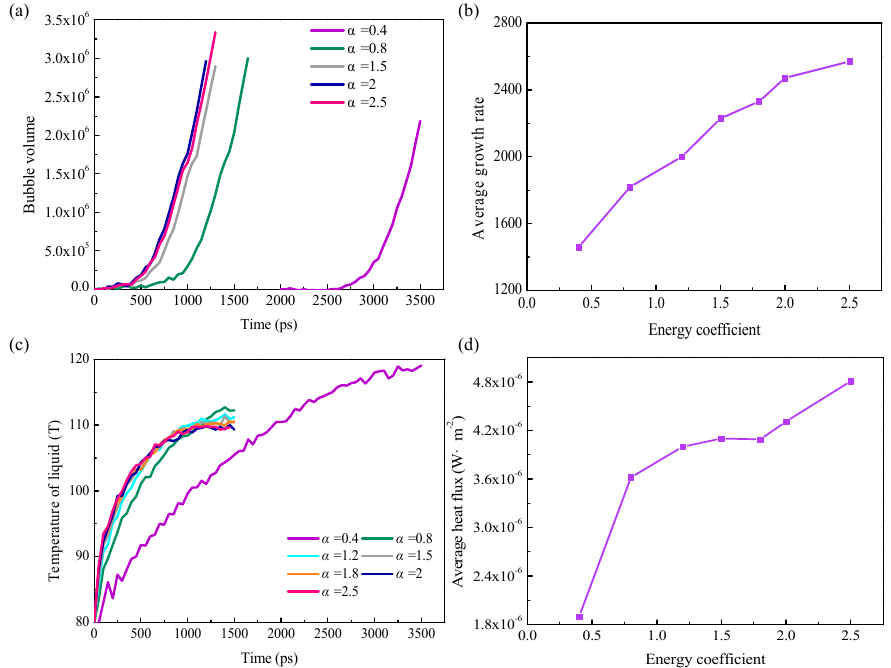
Figure 7. Quantitative investigations of the boiling process with different solid–liquid interactions. ( a ) The time evolution of the bubble growth curve; ( b ) The average bubble growth rate with different solid–liquid interactions; ( c ) The time evolution of temperature in the liquid film near the bottom wall; ( d ) The average heat flux with different solid–liquid interactions.